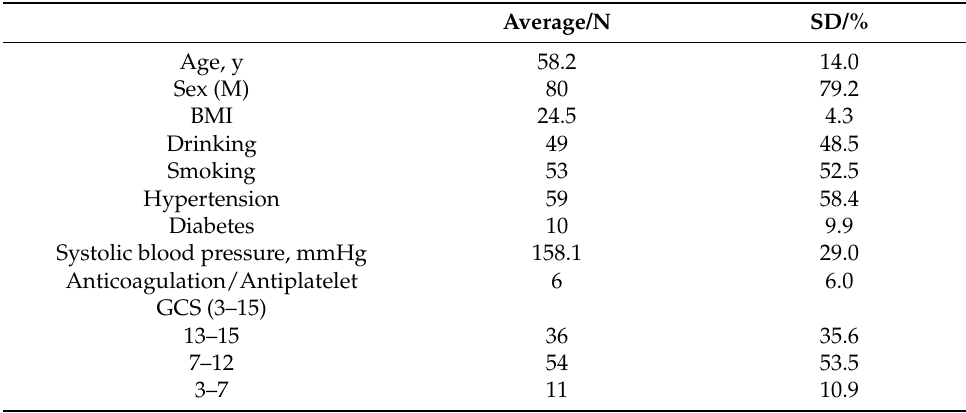
Figure 1. Flow chart of patients’ selection. Table 1. Demographic and Clinical Data.